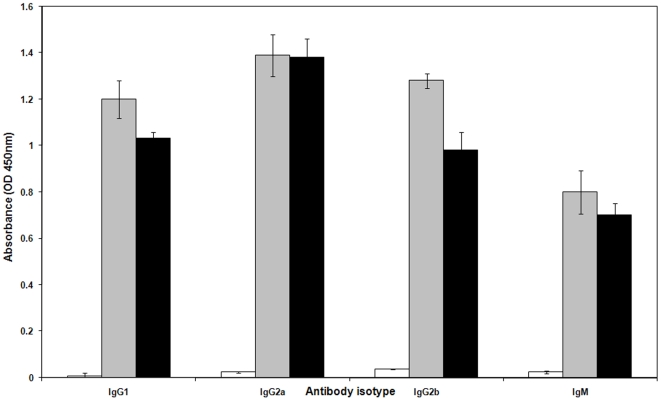
Analysis of OmpA-specific polyclonal antibody isotypes in immunised BALB/c mice.Mice were immunised with 50 µg of recombinant Omp3 or Omp7. The sera were collected (n = 4) prior to and after immunisation and pooled. The levels of IgG subclasses and IgM were determined by ELISA. Data represent the mean absorbance (OD450nm)±SEM. The IgG2a/IgG1 ratio of Omp3-immunised mice is 1.2 while for Omp7-immunised mice, the ratio is 1.3. Open bars represent pre-immunised sera, grey bars represent anti-Omp3 antibody and black bars represent anti-Omp7 antibody.